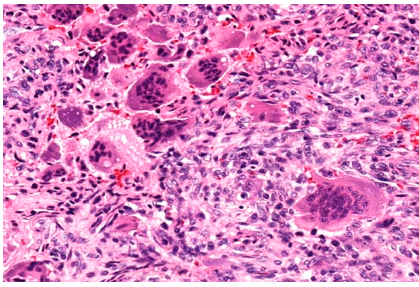
Figure 4. Case 3. GCT of bone. Presence of numerous multinucleate osteoclast-like giant cells scattered throughout the stromal mononuclear cells. H&E staining, ×400.